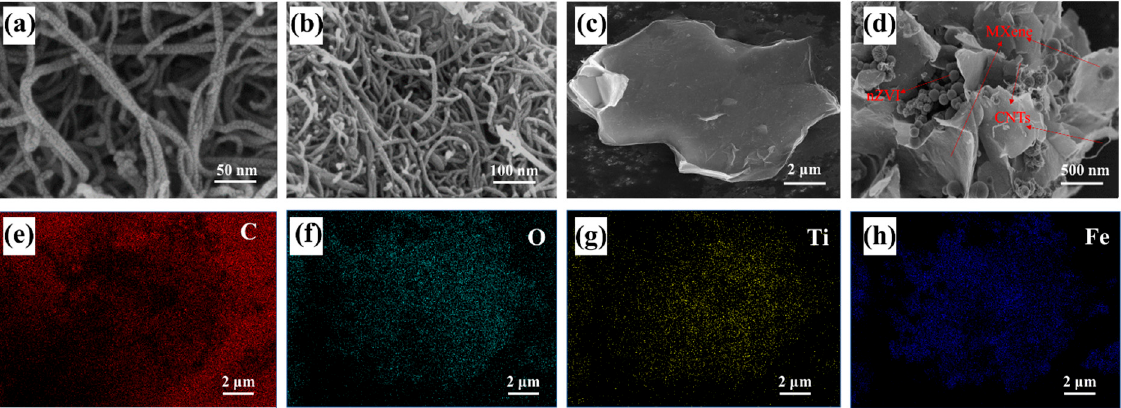
Figure 2. SEM images of ( a ) CNTs; ( b ) functionalized CNTs; ( c ) Ti 3 C 2 T x MXene; ( d ) nZVI/MXene@CNTs, and its EDS-mapping element images of ( e ) C; ( f ) O; ( g ) Ti; ( h ) Fe.